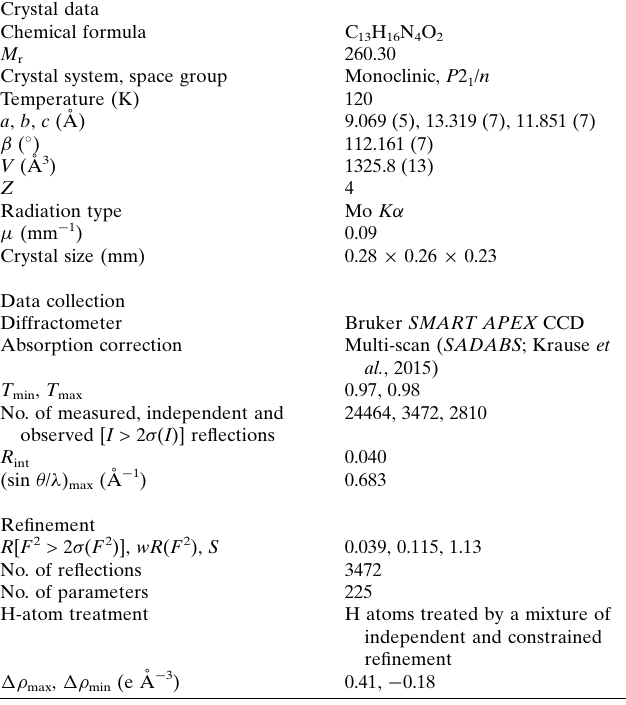
Table 1 Hydrogen-bond geometry (A˚ , (cid:4) ).